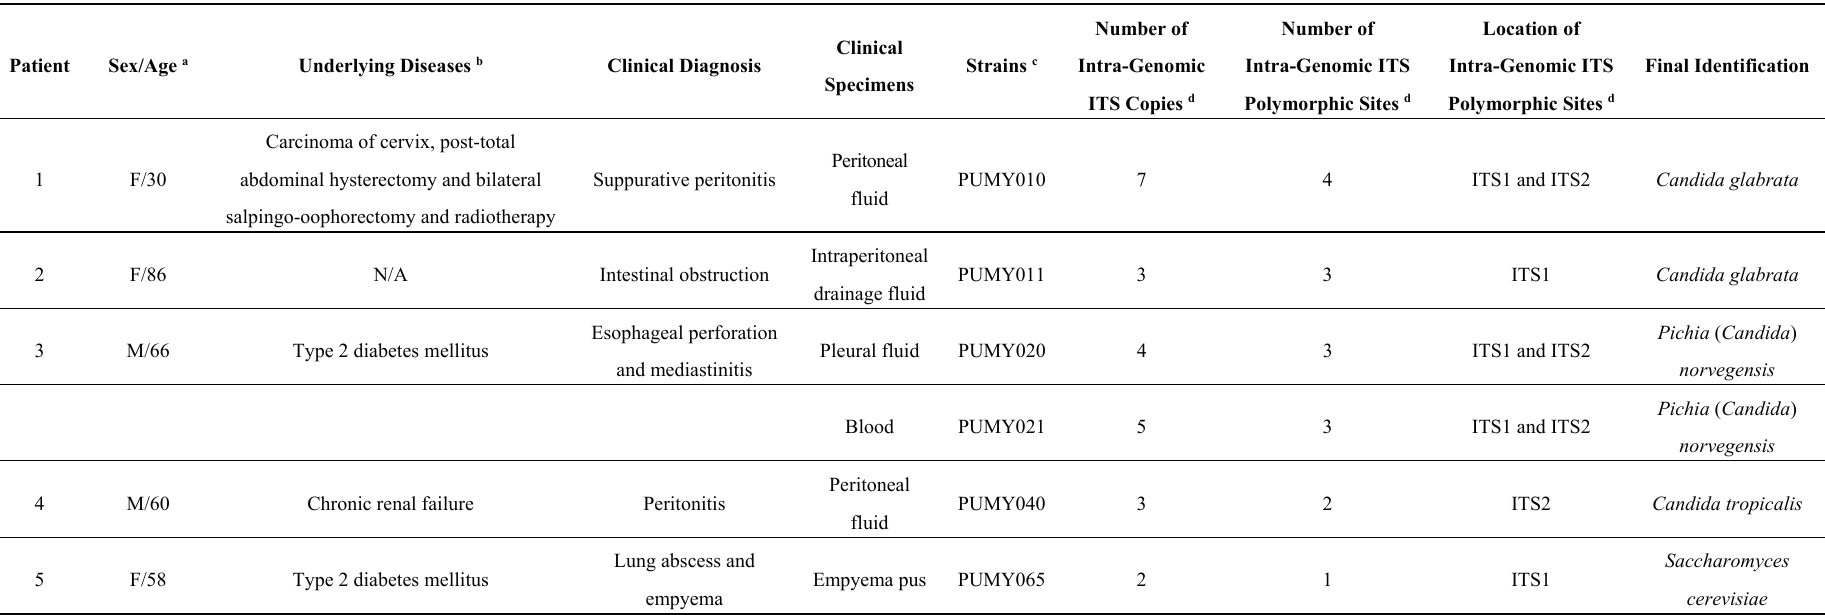
Table 1. Characteristics of the six yeast strains in this